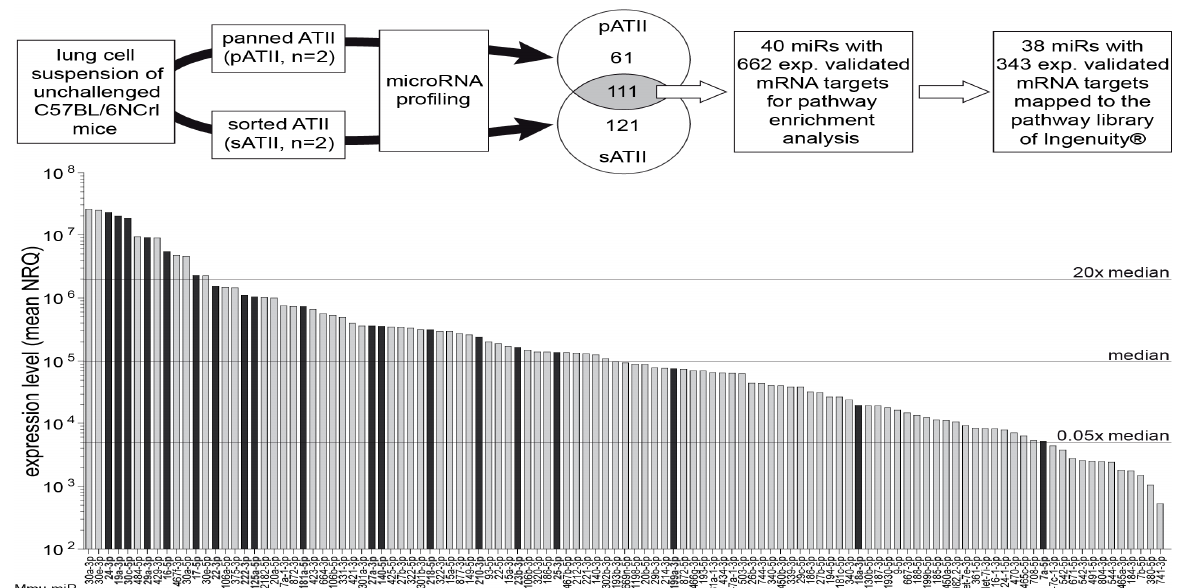
Figure 4. Workflow and miRNA expression profile of ATII cells. Lung single-cell suspensions were generated from unchallenged female C57BL/6NCrl mice. ATII cells were isolated either by negative selection (panning, pATII, n = 2) or by cell sorting (sATII, n = 2). Both cell preparations were subjected to miRNA profiling using TaqMan ® array microfluidic cards (Life Technologies). In pATII and sATII, respectively, 61 and 121 miRNAs had fold differences larger than 1.5 (FC > 1.5). A cut set of 111 miRNAs with similar expression levels (|fold difference| ≤ 1.5) in pATII and sATII was identified and is represented as a bar diagram. For 40 of these bona fide ATII miRNAs, experimentally observed interactions with 662 mRNA targets were available in the Ingenuity ® database and this information was used for pathway enrichment analysis, resulting in 38 miRNAs targeting 343 mRNAs in 145 pathways. Black bars indicate 19 miRNA targeting components of the TGF- β signaling pathway. The majority (16 out of 19) of these miRNAs were expressed above median level. A complete list of the miRNAs expressed in ATII cells is available as a spreadsheet file (see Table S2 supplementary material). n = 2 represents a biological replicate.